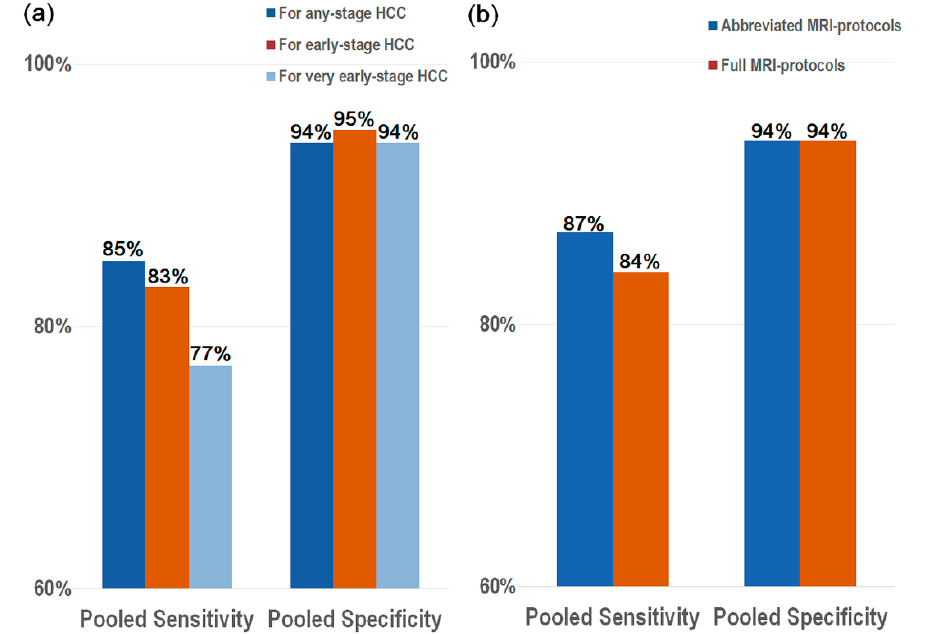
Figure 4. Performance of surveillance MRI for the detection of HCC according to ( a ) HCC staging and ( b ) MRI protocol. The performance of the abbreviated MRI protocols for detecting any-stage HCC was comparable with those of the full MRI protocols ( p = 0.83).